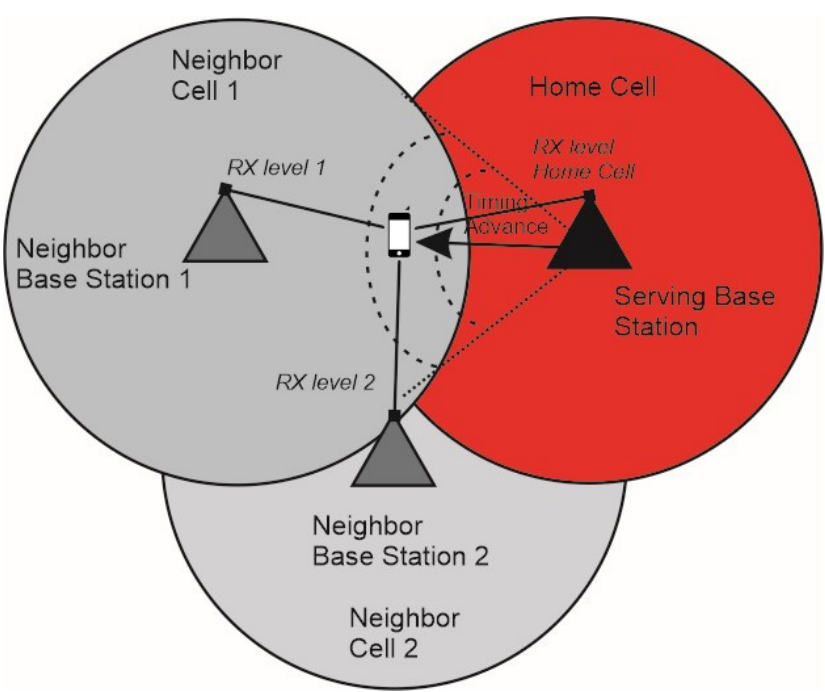
Figure 2. Localization by referring to cell identity, timing advance, and signal strength. Table 2. Characteristics of the primary mobile operator’s database for Moscow region of